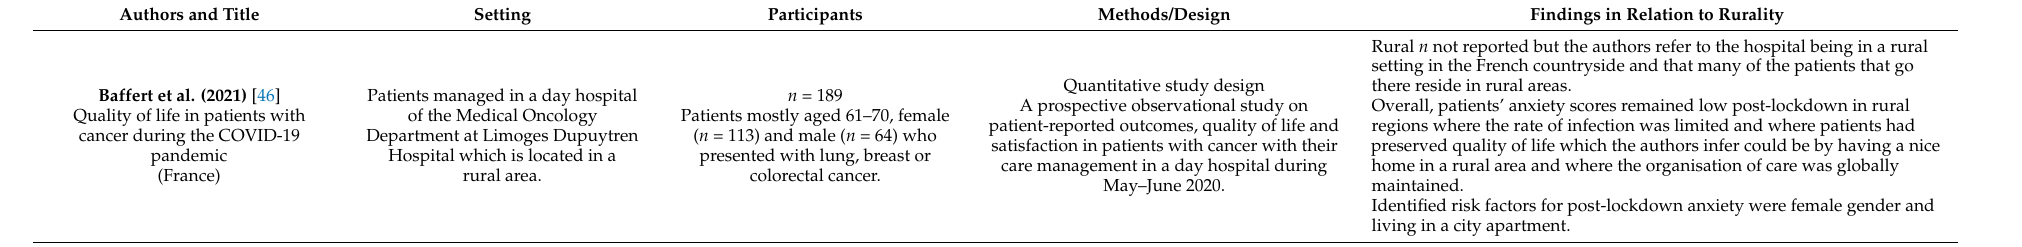
Table 2. Characteristics of included